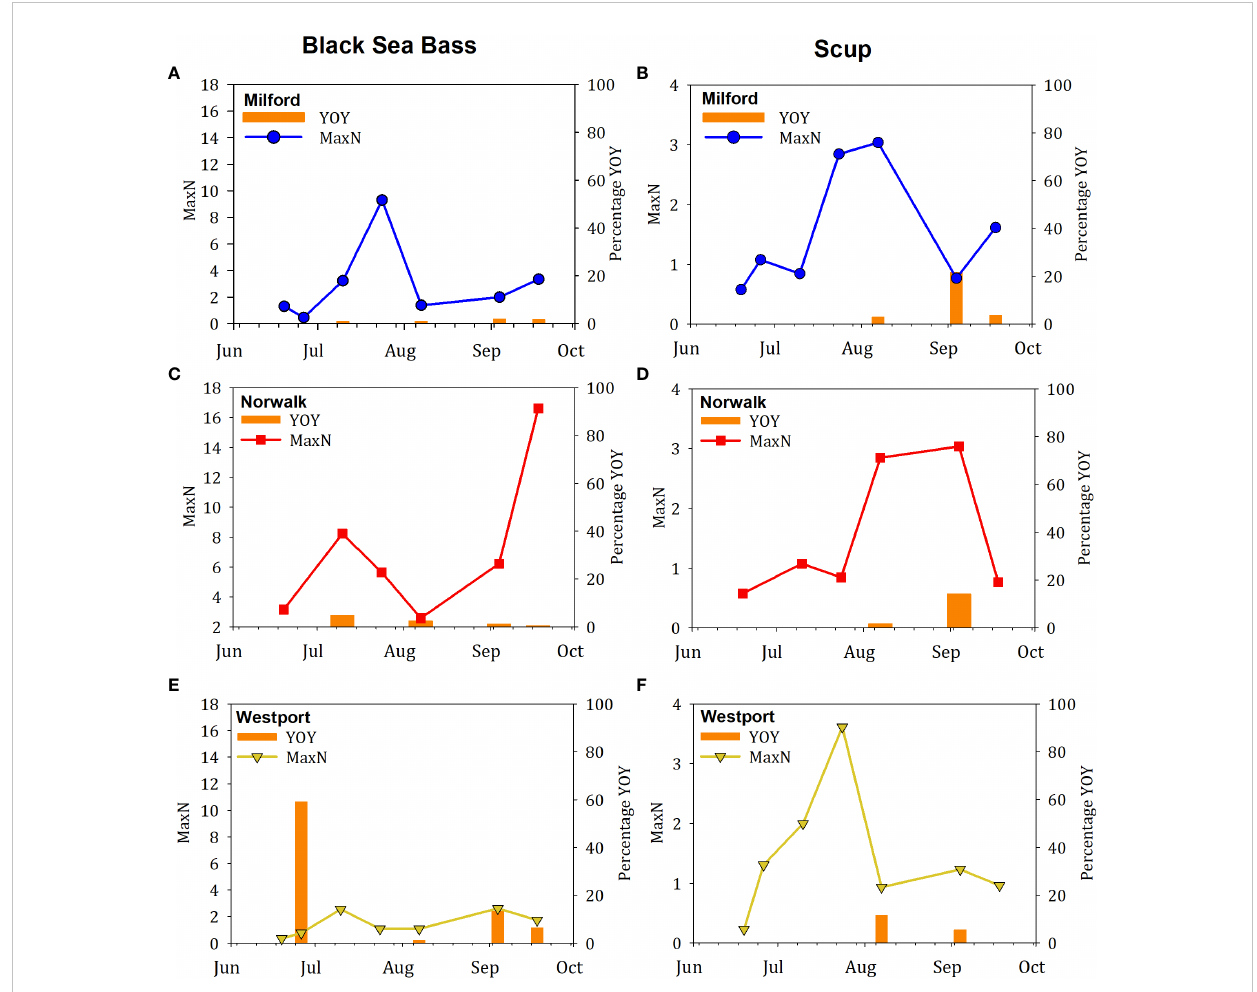
FIGURE 7 Time series of fi sh abundance and proportion of fi sh observed that were young-of-year (YOY) in 2019. In each fi gure, the MaxN abundance is indicated by the line and scatter plot, and the proportion of that abundance that was YOY is indicated by the orange bars. Species included (A, C, E) Black sea bass, (B, D, F) Scup. Farm locations included (A, B) Milford, (C, D) Norwalk, (E, F)